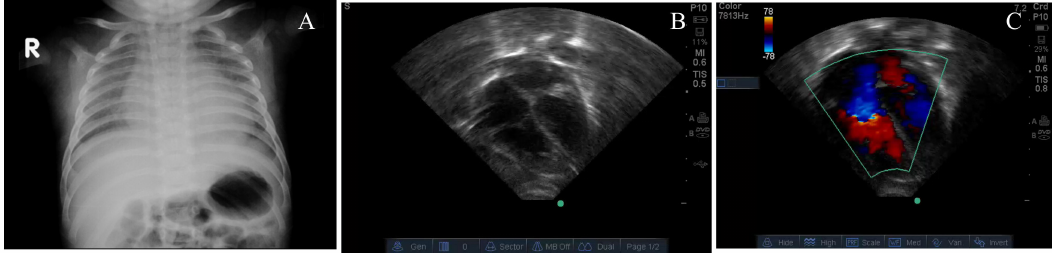
Figure 1. Chest X-ray showing mild cardiomegaly ( A ), four-chamber view of the echocardiogram showing septal flattening ( B ) and color Doppler showing tricuspid regurgitation ( C ) from case #